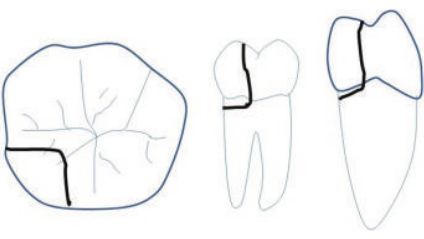
Figure 9: Extent of fracture line in 46.